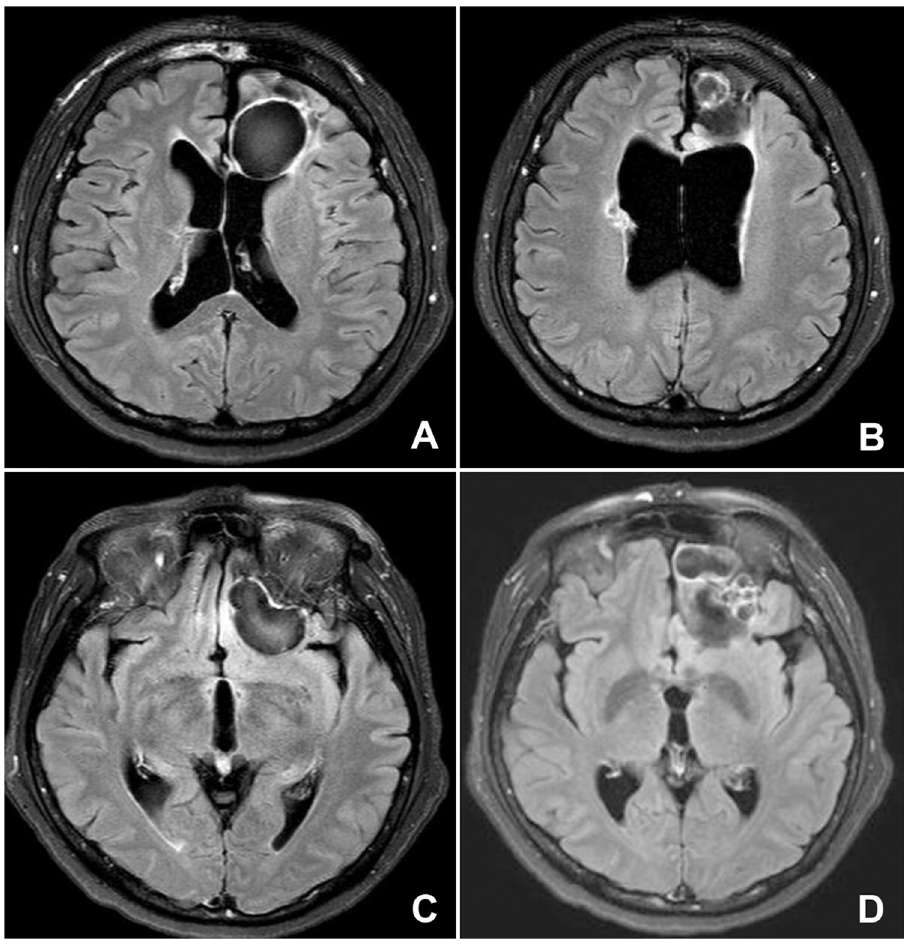
Fig 2. Fluid attenuated inversion recovery (FLAIR) sequence of brain magnetic resonance image of a 68-year-old female patient who suffered from dysarthria and right-sided weakness for 9 years. The laboratory results including eosinophil counts were within the normal range. The patient could not recall the consumption of freshwater crustaceans. The anti- Paragonimus specific IgG antibody levels against adult worm extracts were 0.31 (serum) and 0.26 (CSF), respectively. (A and B) FLAIR sequence shows cerebromalacia and ventriculomegaly with a round calcified mass on the left frontal lobe. (C and D) Several well-defined calcified masses in the left inferior frontal lobe are